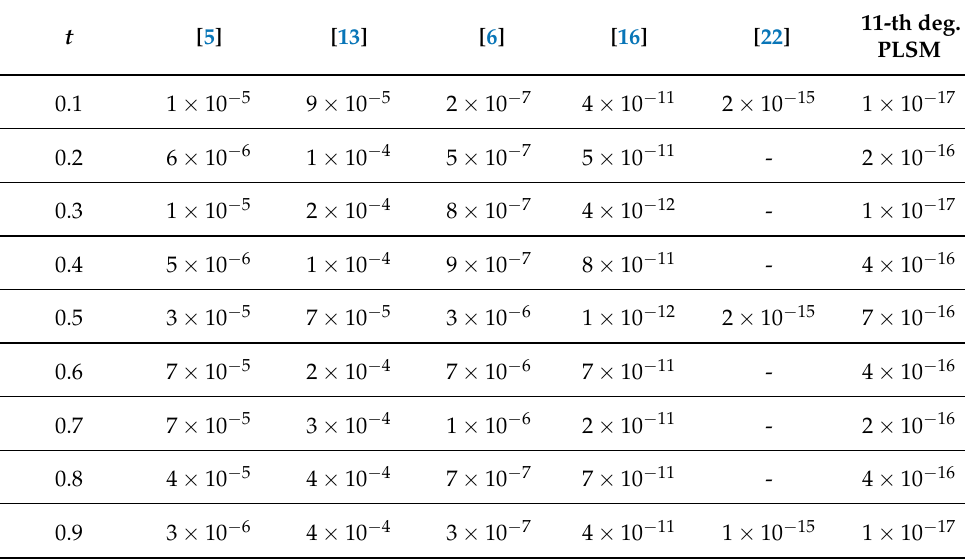
Table 2. Comparison of absolute errors of x 2 for problem (17) in the case α 1 = α 2 = 1.